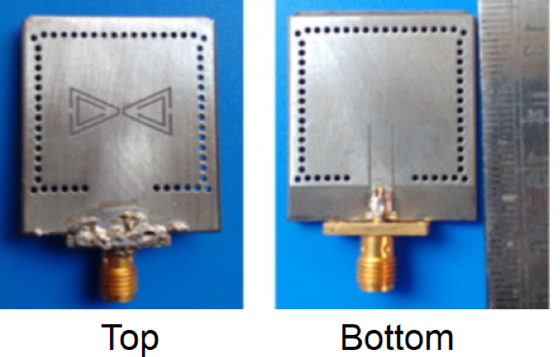
Figure 18. Dual-frequency SIW-based cavity-backed PCB-based antenna. ( Top ): top view where a pair of triangular-complementary-split-ring slots, and vias can be seen; and ( Bottom ): bottom view where the vias can be seen. (reprinted from [229], copyright (2018), with permission from